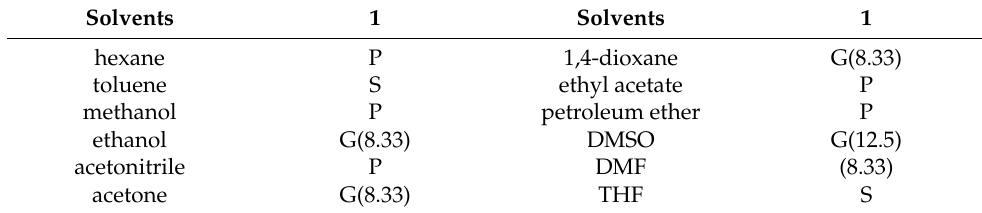
Table 1. Gelation ability of gelator 1 in different